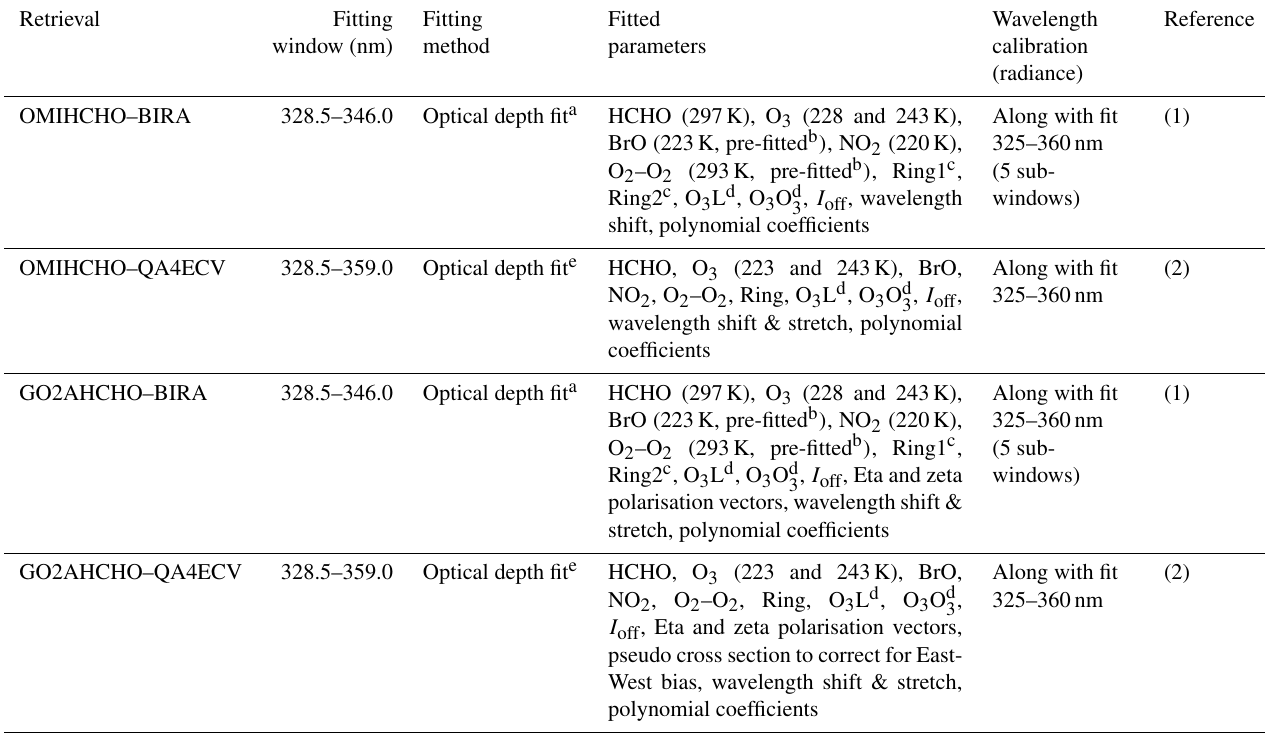
Table 3. Satellite HCHO slant column density retrievals evaluated in this